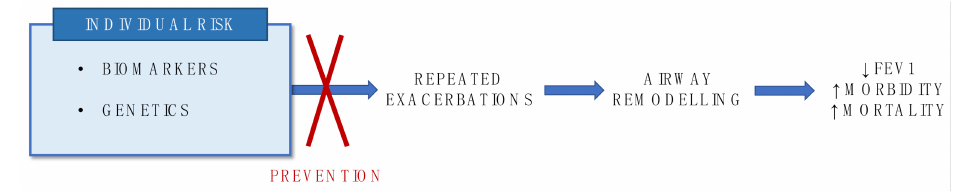
Figure 1. Biomarkers and genetics as useful tools to identify asthma exacerbators at risk of lung function